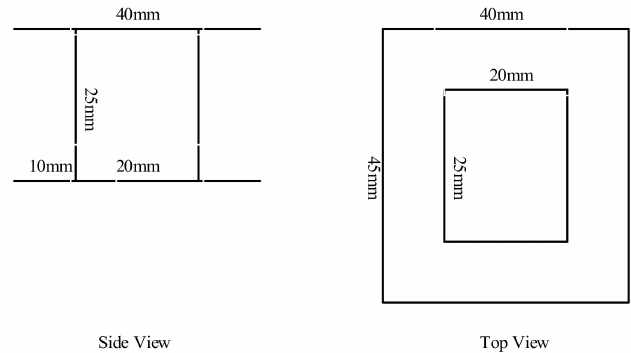
Figure 2. Side and top views of the coil support.